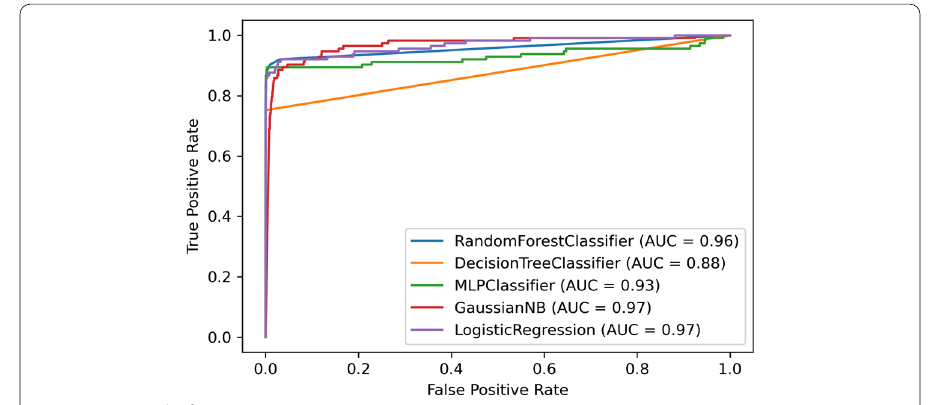
Fig. 4 AUC results for v 1